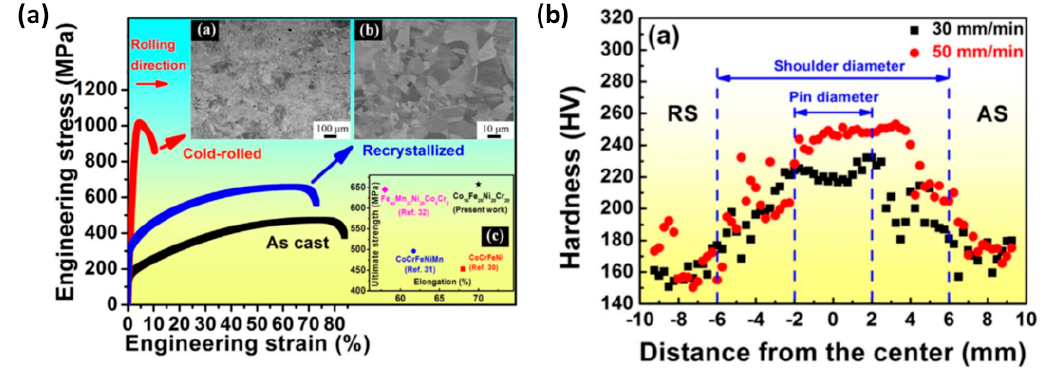
Figure 9. Sample characterization: ( a ) Tensile properties; ( b ) microhardness distribution (Adapted from [88], with permission from Elsevier, 2018).